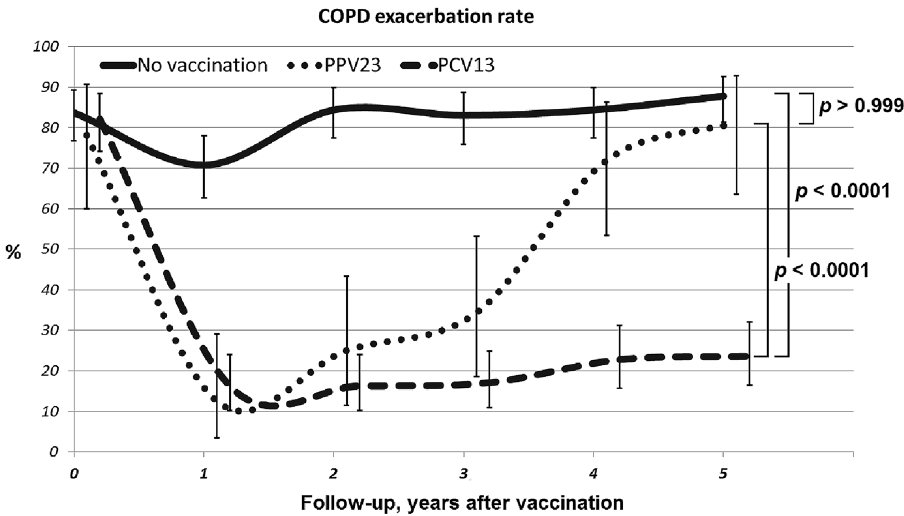
Figure 2. Dynamics of the COPD exacerbation rate in the different study groups. The p value shows ANOVA statistics between groups.